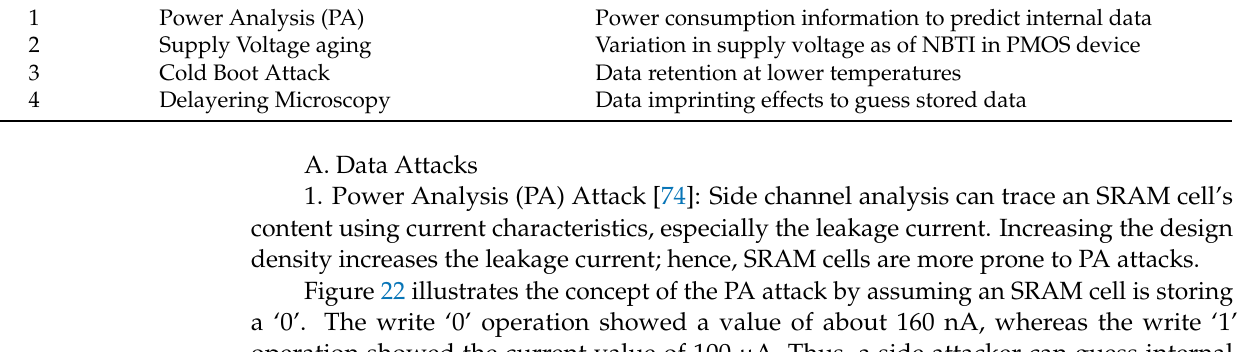
Figure 21. Matrix errors’ correcting codes for error detection and correction [71].